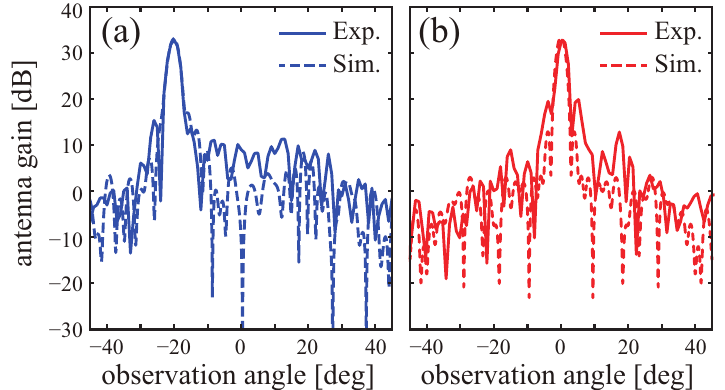
Figure 8. Experimental (solid) and simulated (dashed) far-field radiation patterns of proposed two- bit digitized reconfigurable reflectarray antennas when two different observation angles are applied. ( a ) θ = − 20 ◦ ; ( b ) θ = 0 ◦ .